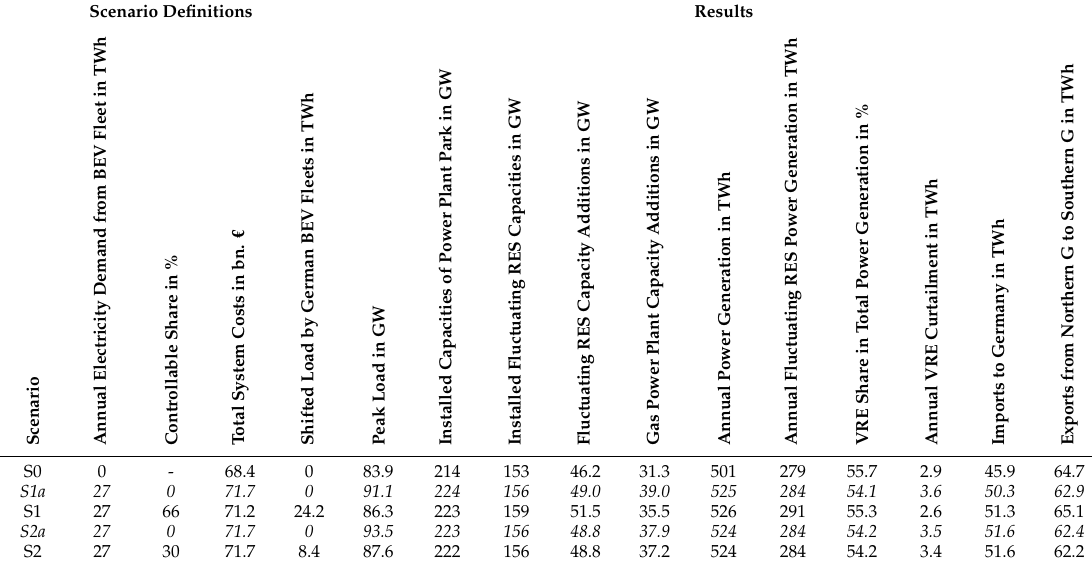
Table 8. Overview on scenario definitions and main annual results of the four main scenarios under analysis. Total system costs are given for the complete system boundary while all other values are given for Germany. Di ff erence in total system costs between S2a and S2 is more than an order below numbers shown. Source: Own